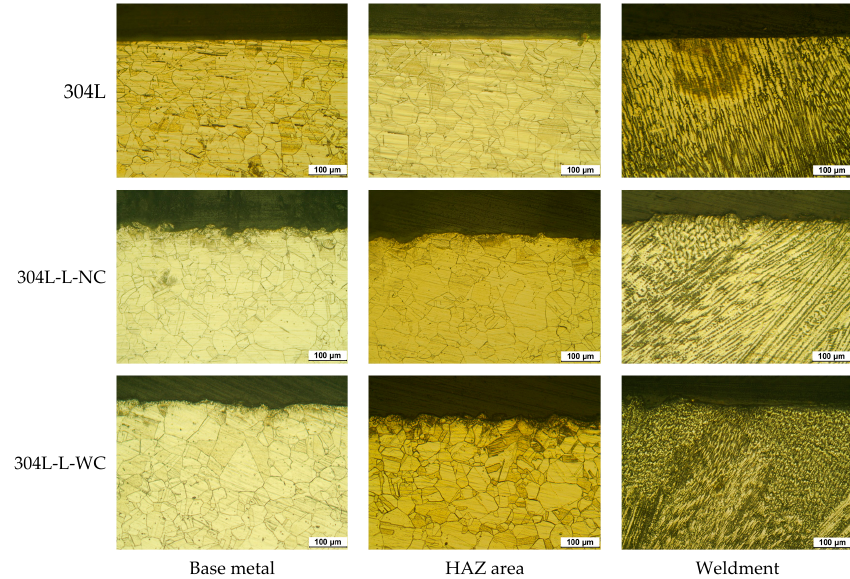
Figure 5. Cross-sectional appearance of 304L after DL-EPR test (OM, ×200).